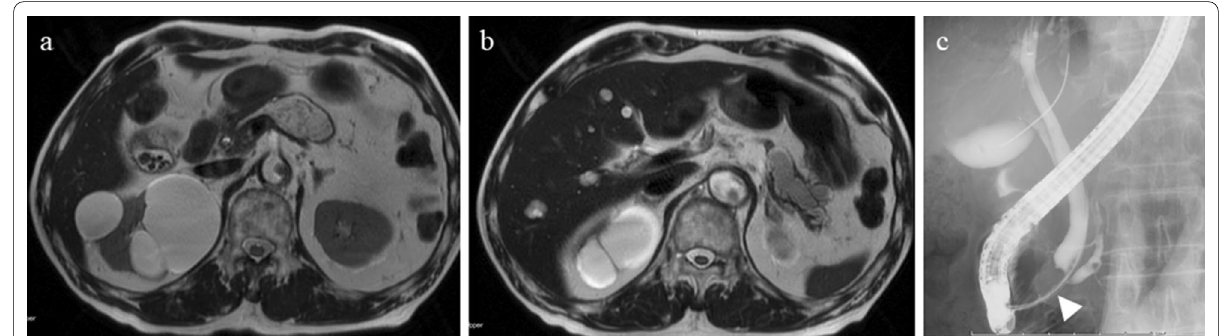
Fig. 1 Preoperative imaging findings. a T2-weighted MRI showed a cystic tumor, 48 mm in diameter, in the pancreatic body. b Size of the main pancreatic duct was 18 mm in the pancreatic tail. c ERCP showed that the length of the common channel connecting the bile duct and pancreatic duct was 12 mm (arrowhead)